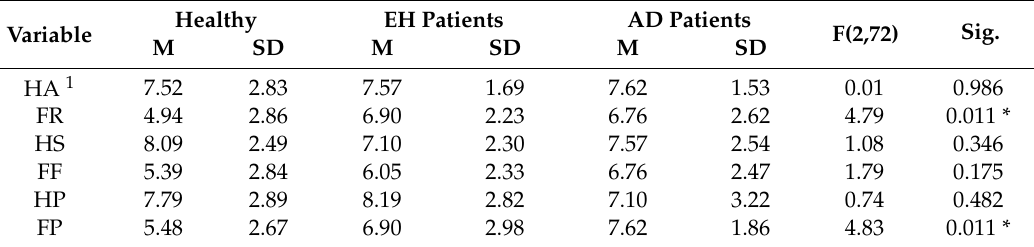
Table 2. Di ff erences in motivation measured by MMG.